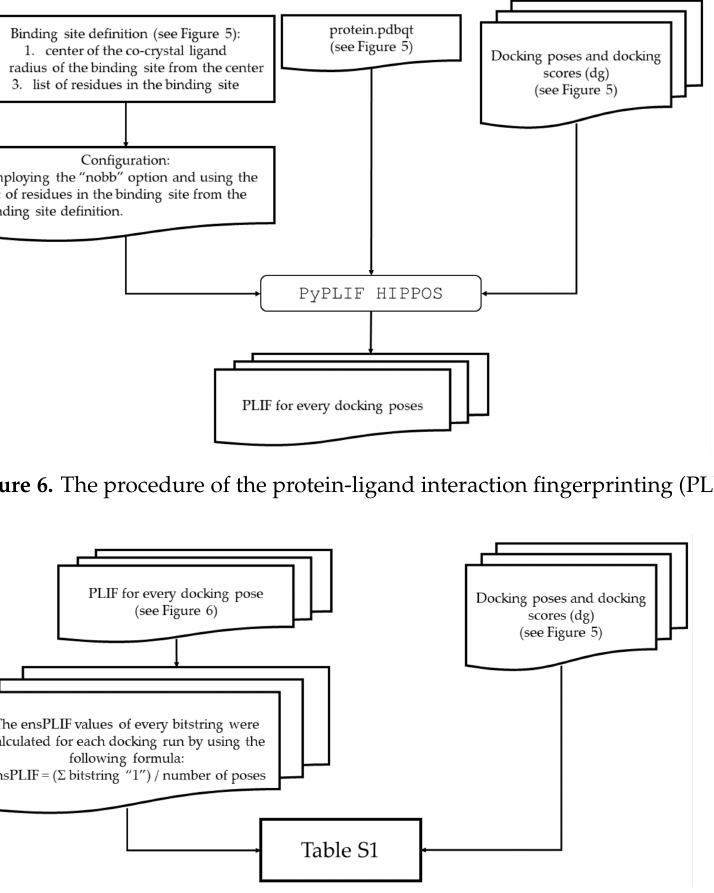
Figure 7. The calculation of ensPLIF [13] and the creation of Table